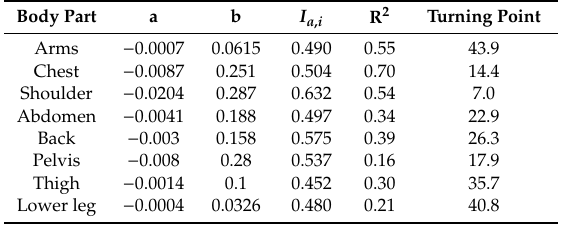
Table 3. Coe ffi cients of the regression equations for eight di ff erent body